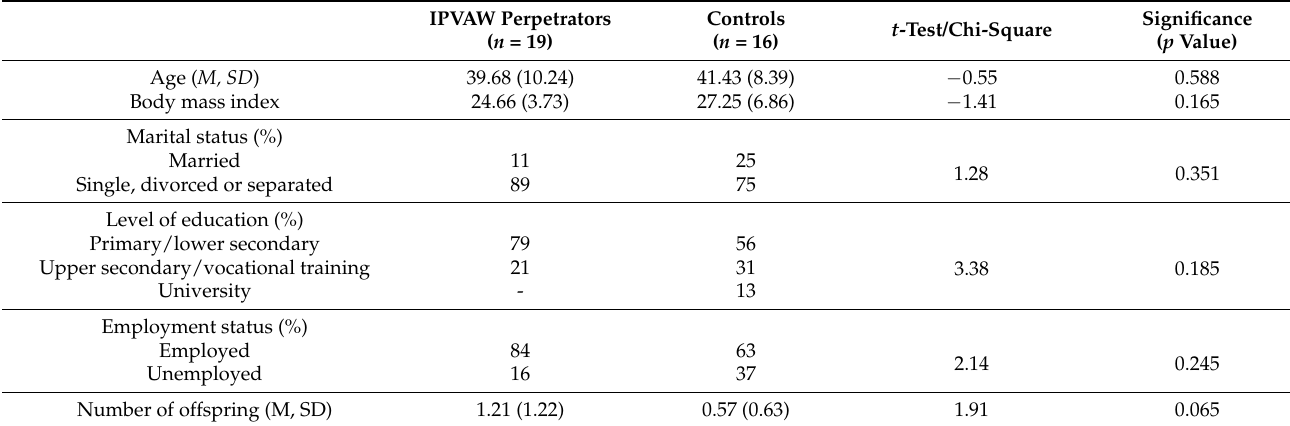
Table 1. Means (Standard Deviations), Percentages, and Means Comparisons for Anthropometric (age and body mass index) and Demographic Variables in All